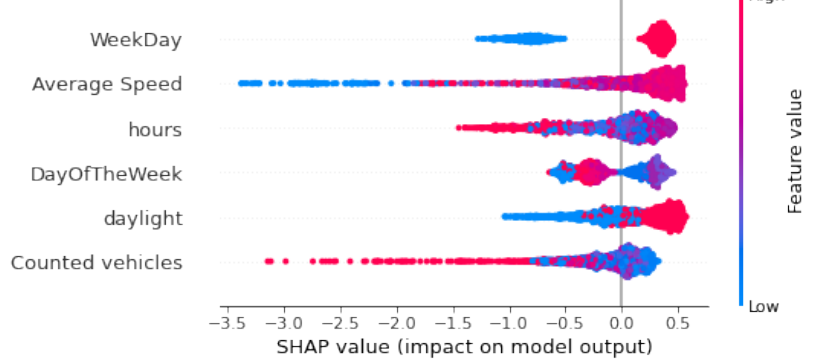
Figure 8. Distribution of SHAP values for each feature, sensor “MS734”.